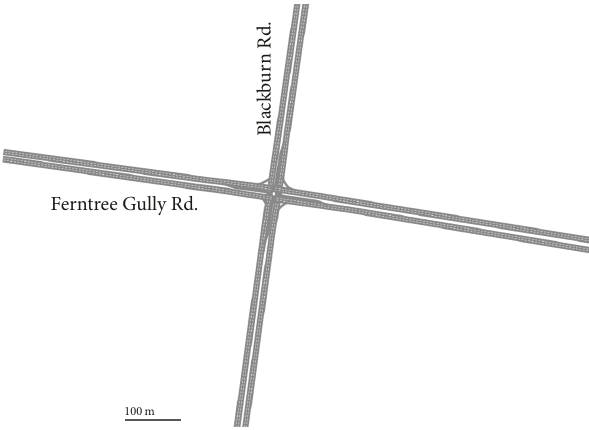
Figure 4: Signalised intersection case